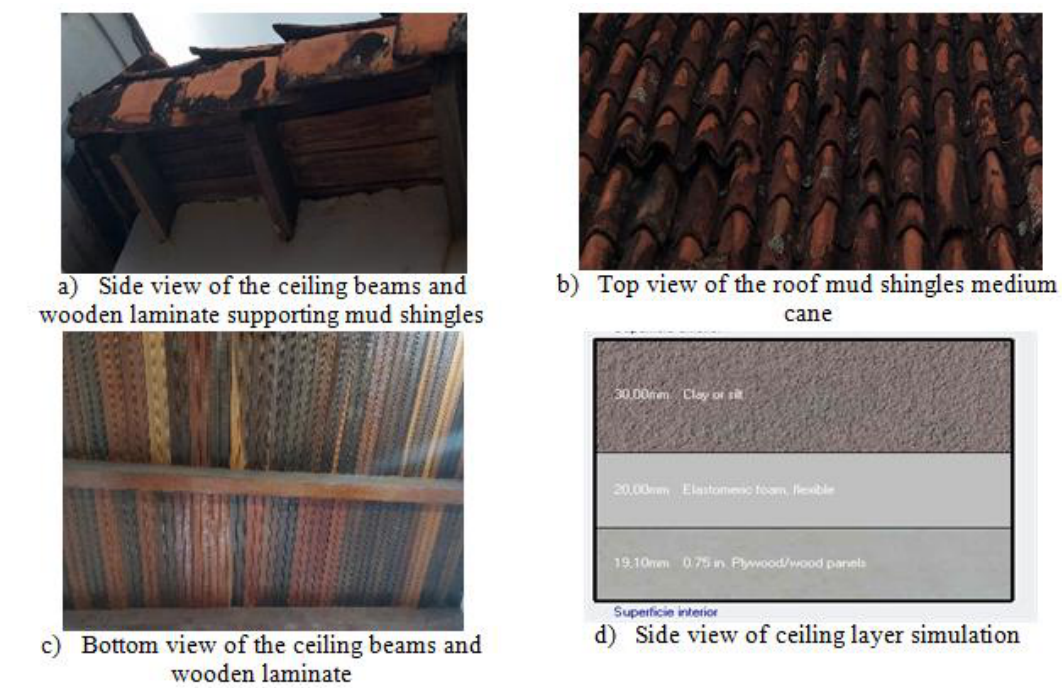
Figure 1. State construction of the current roof of the studio house composed of wood, elastomeric waterproofing enclosure and mud